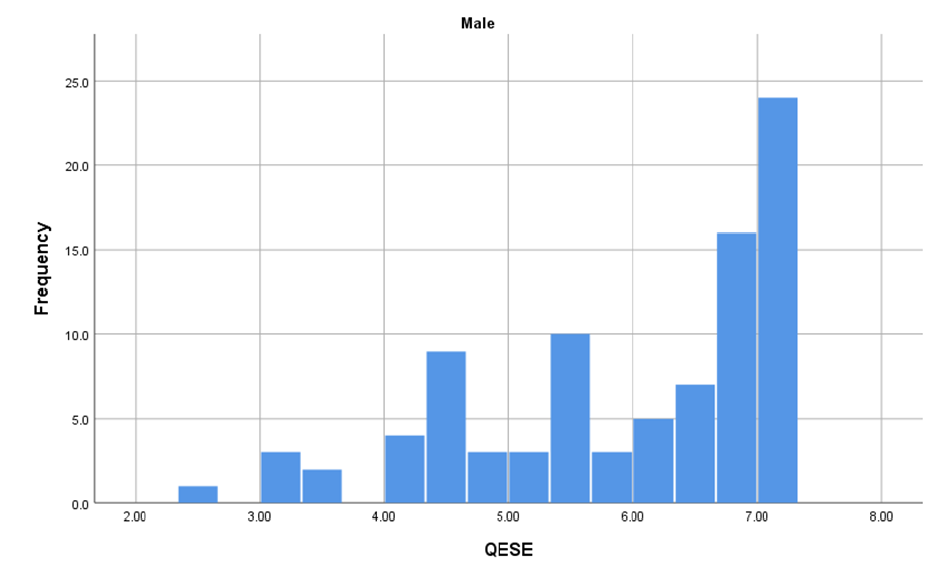
Figure 4. Distribution of scores for the QESE scale for male